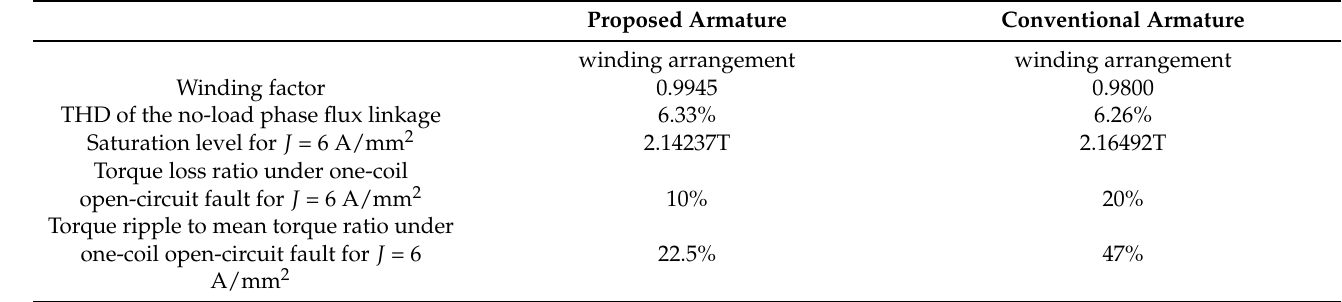
Table 2. Comparison of the features of the FSPMSM under study when equipped with the proposed armature winding and when equipped with the conventional